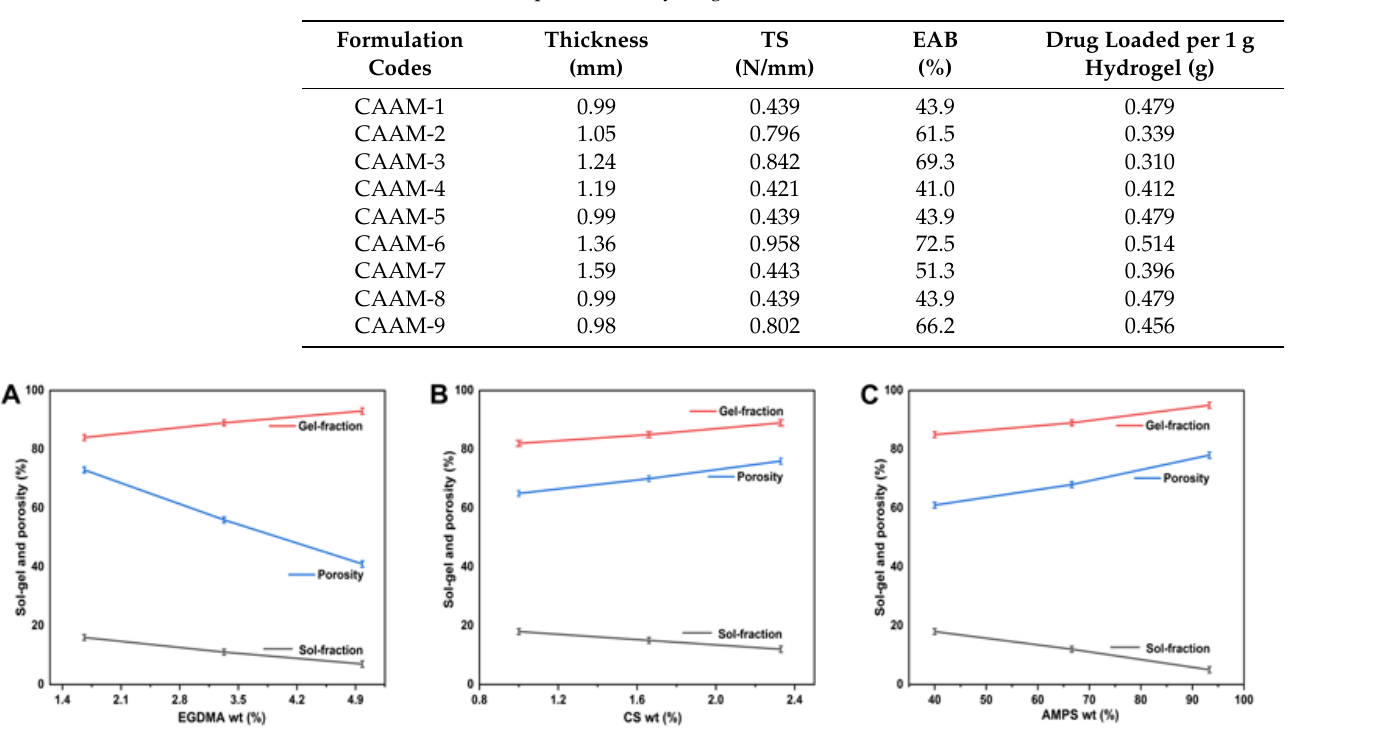
Figure 3. Effect of EGDMA ( A ), CS ( B ), and AMPS ( C ) sol–gel and porosity of CS- g -AMPS hydrogel.